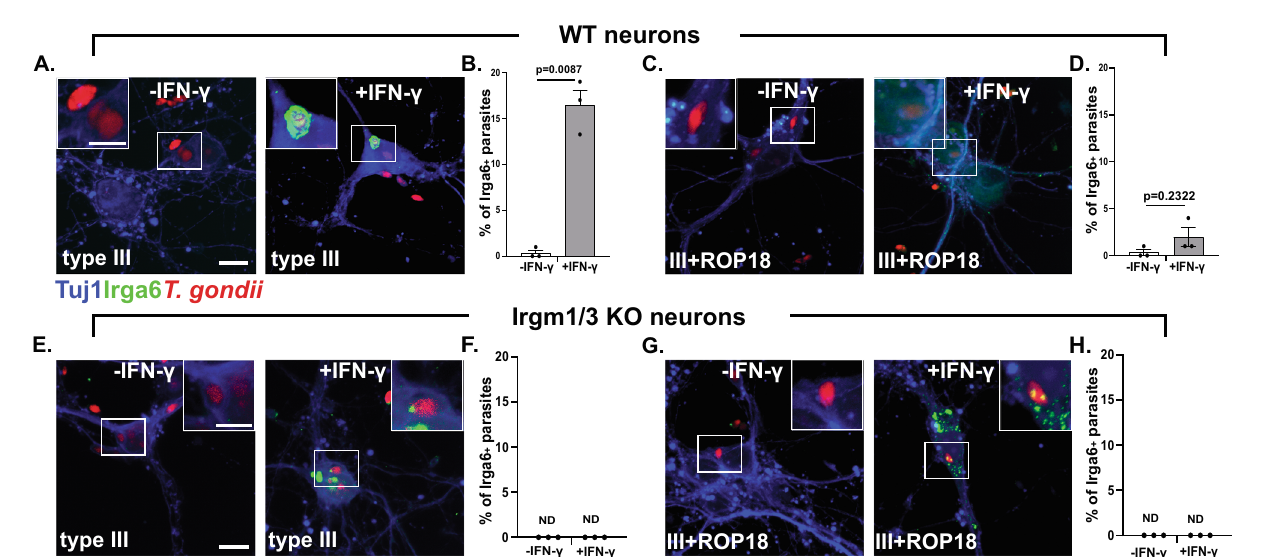
Fig.3|IFN- γ stimulatedwildtypemurineshowincreasedloadingofIrga6onto the PVM of type III parasites. Primary neuron cultures were treated as in Fig. 1, followed by infection with listed T. gondii strains. At12 hpi cultures were fi xed and stainedwithanti-Irga6andanti-Tuj1antibodies.Thestainedcultureswereanalyzed by confocal microscope. A Representative images of stained cultures from wild type (WT) mice infected with type III parasites. Blue=anti-Tuj1 antibodies, green=anti-Irga6 antibodies, red=mCherryexpressing parasites. B Quanti fi cation ofthepercentageofIrga6 + parasitophorousvacuoles(PVs)inthesettingofvehicle